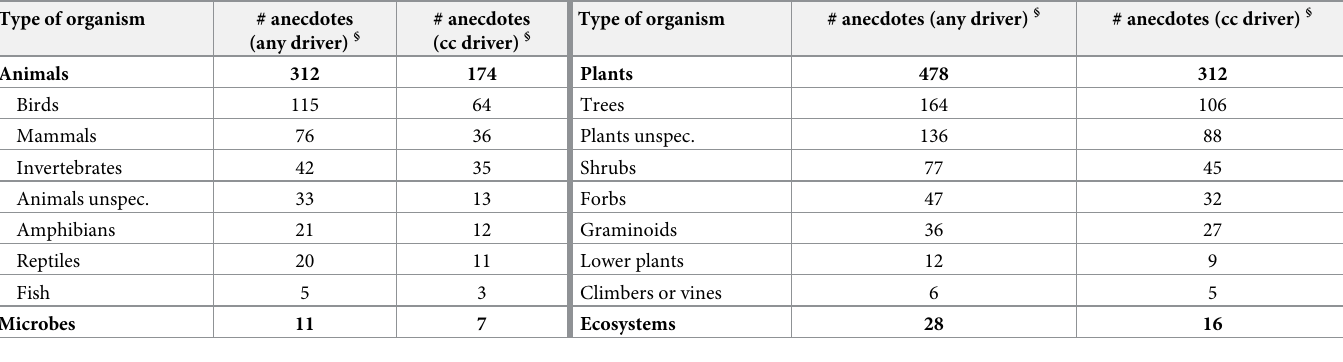
Table 5. Types of organisms observed to have undergone recent ecological change in Australia. Type of organism